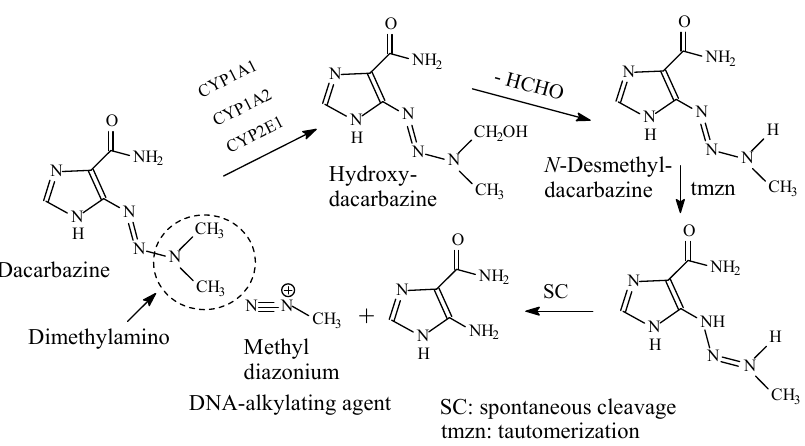
Figure 41. Metabolic activation of dacarbazine.